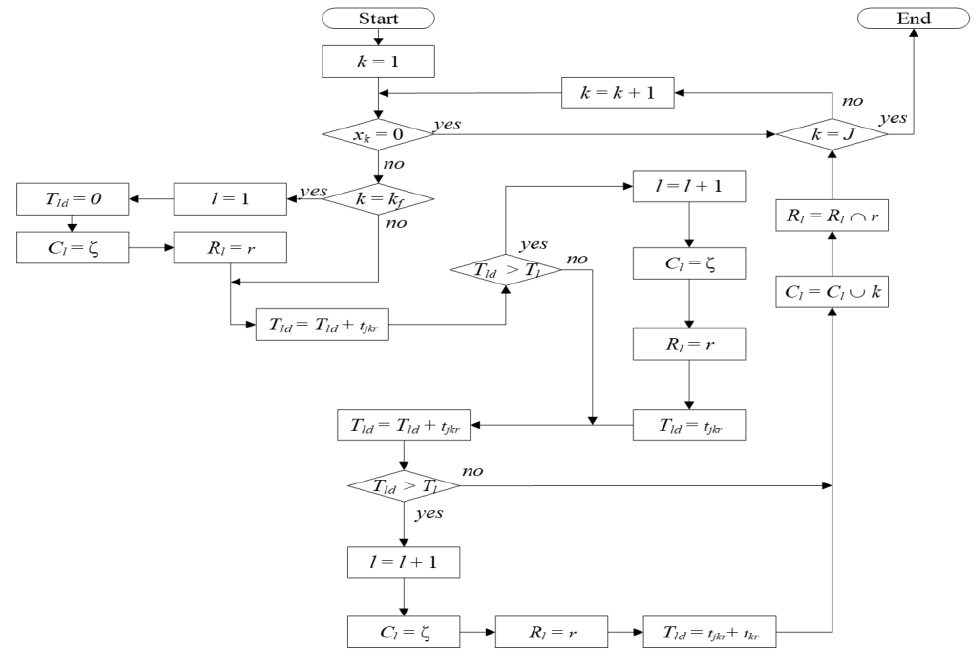
Figure A1. The flowchart of decoding.